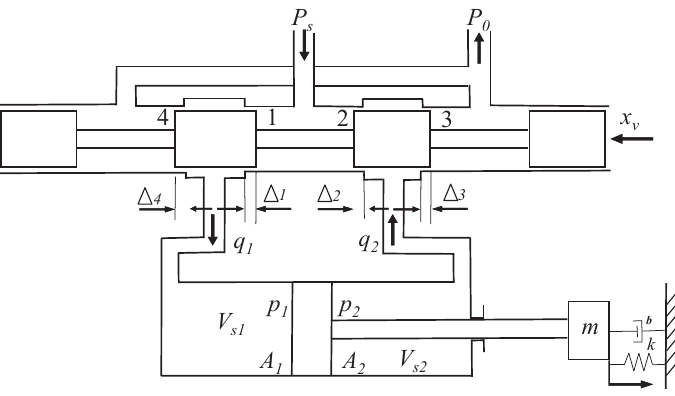
Figure 2. Principle diagram of valve-controlled asymmetrical cylinder